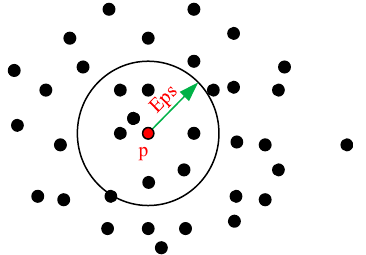
Figure 1. Neighborhood definition.